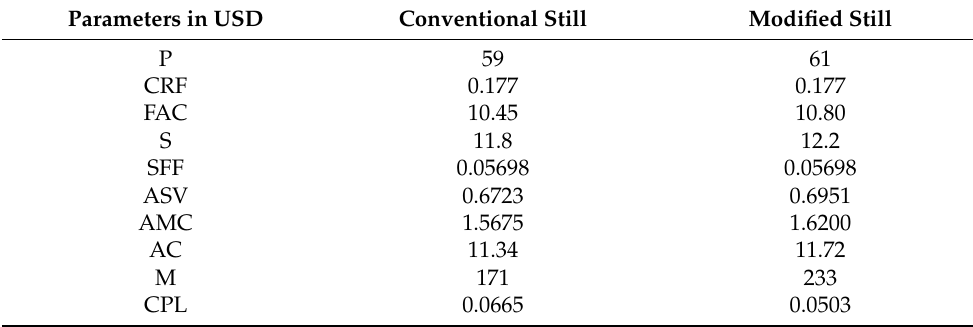
Table 3. Economical comparison between the MSS and the CSS in USD.